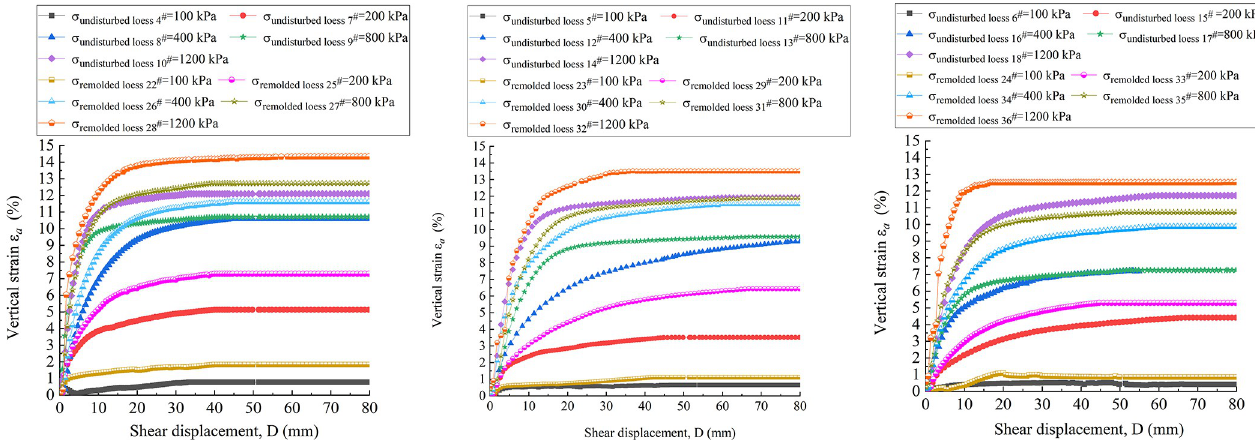
Fig 16. Vertical strain-shear displacement curve of 4 # - 18 # undisturbed and 22 # - 36 # remolded loess specimens under different vertical pressure. (A) Vertical strain-shear displacement curve of 4 # , 7 # - 10 # undisturbed and 22 # , 25 # - 28 # remolded loess specimens ( w = 16%). (B) Vertical strain-shear displacement curve of 5 # , 11 # - 14 # undisturbed and 23 # , 29 # - 32 # remolded loess specimens ( w = 19%). (C) Vertical strain-shear displacement curve of 6 # , 15 # - 18 # undisturbed and 24 # , 33 # - 36 # remolded loess specimens ( w = 22%).